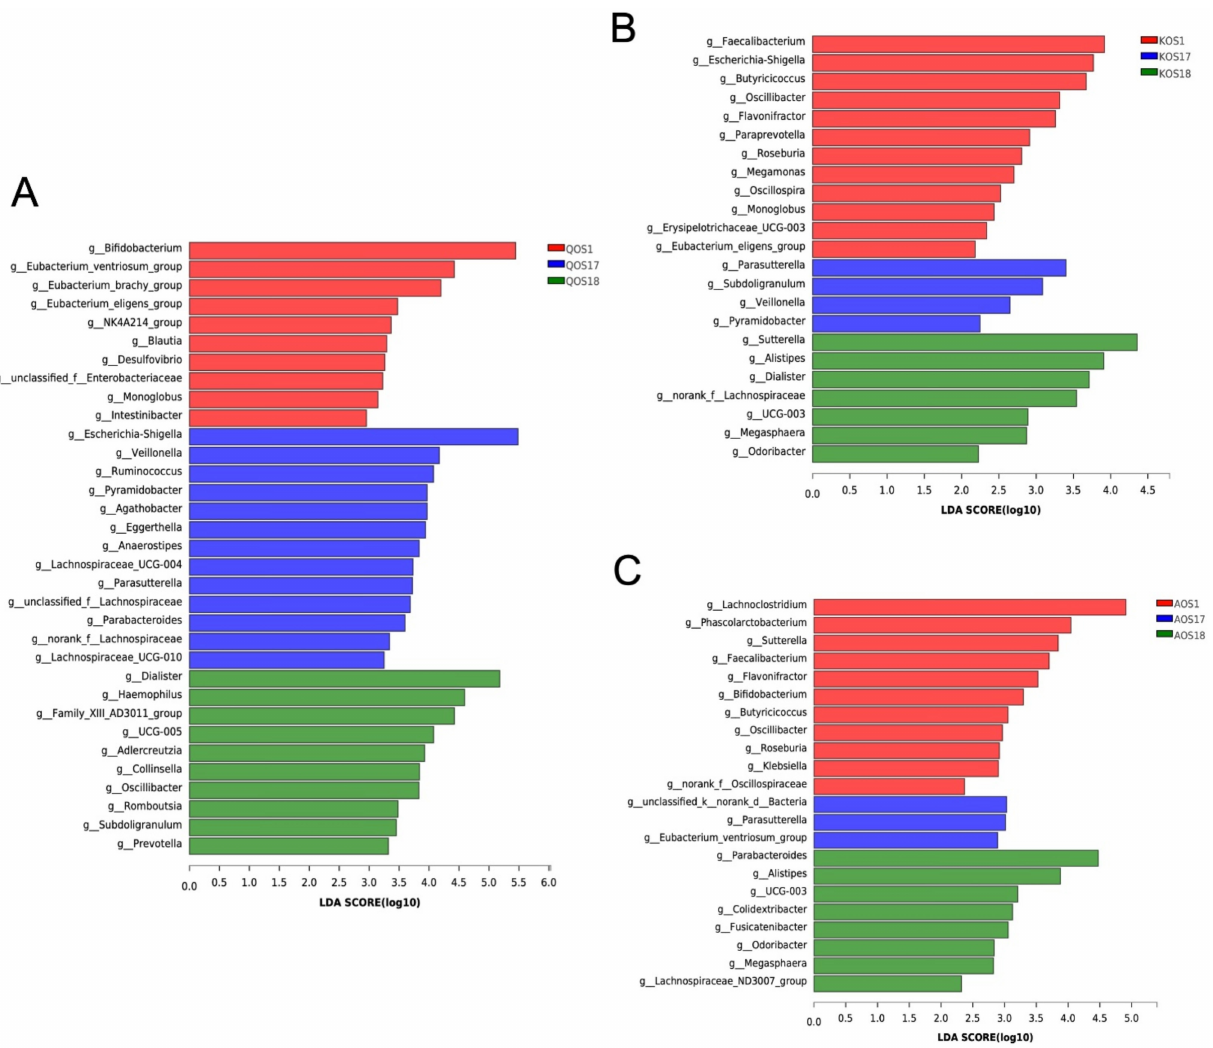
Figure 5. LEfSe LDA analysis of the microbiota during fermentation of QOS ( A ), KOS ( B ), and AOS ( C ). The analysis was performed at the genus level. Only taxa with an LDA score >2 are listed. QOS1 denotes fermentation of QOS by gut microbiota F1. QOS17 denotes fermentation of QOS by gut microbiota F17. QOS18 denotes fermentation of QOS by gut microbiota F18. Each fermentation group has three replicates. KOS and AOS were labeled using the same format. The LEfSe analysis was performed at the genus level. Only taxa with an LDA score >2 are